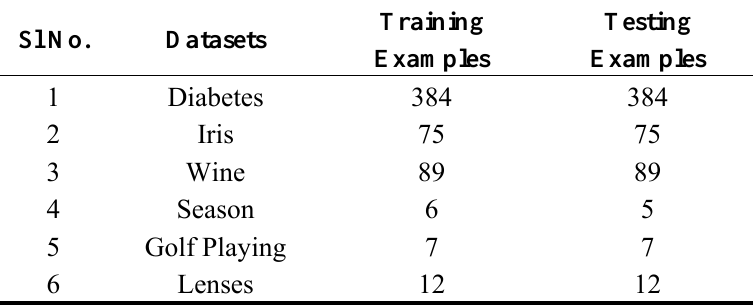
Table 2. Sizes of the training and the testing